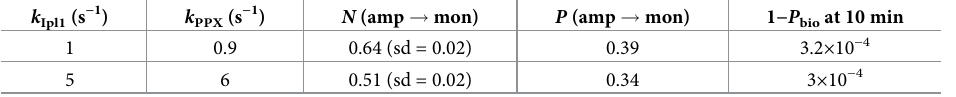
� The number of transitions is converted into probability using P = N /(1+ N ). At higher absolute values of activities, the probability of amphitelic to monotelic transition